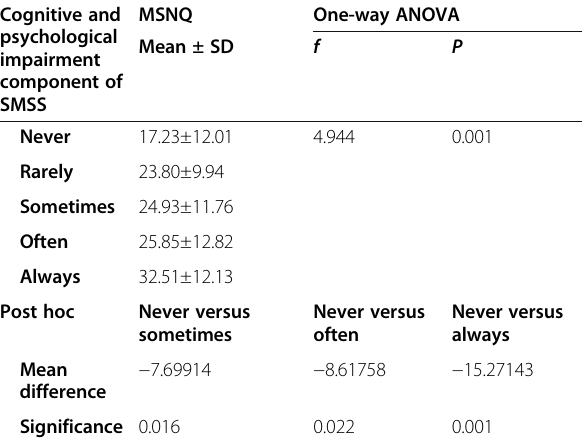
Table 6 Comparison of EDSS scores in the bodily dysfunction component of SMSS